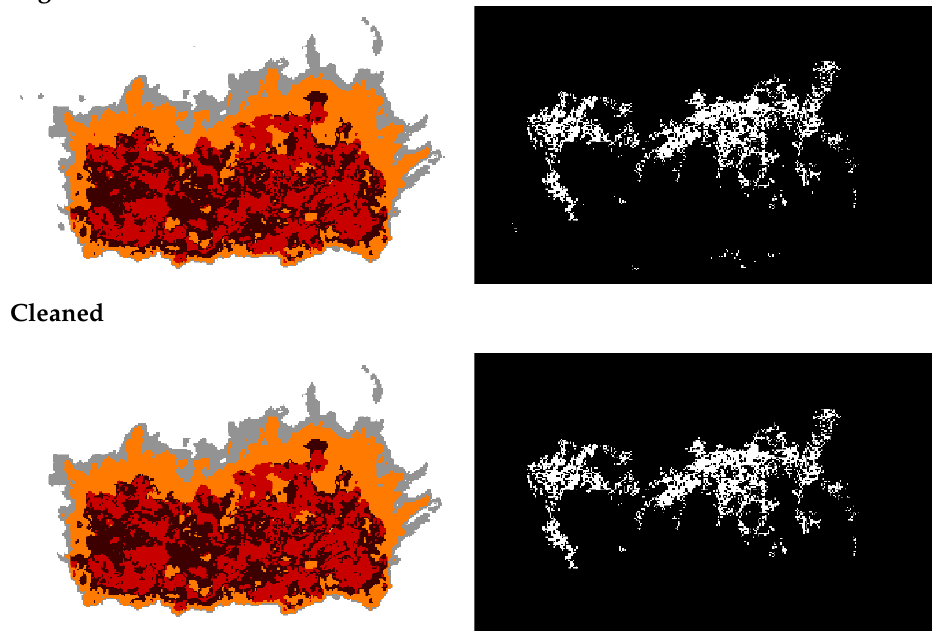
Figure 7. ( Top ): Segmented infrared and visual images. ( Bottom ): Cleaned infrared and visual